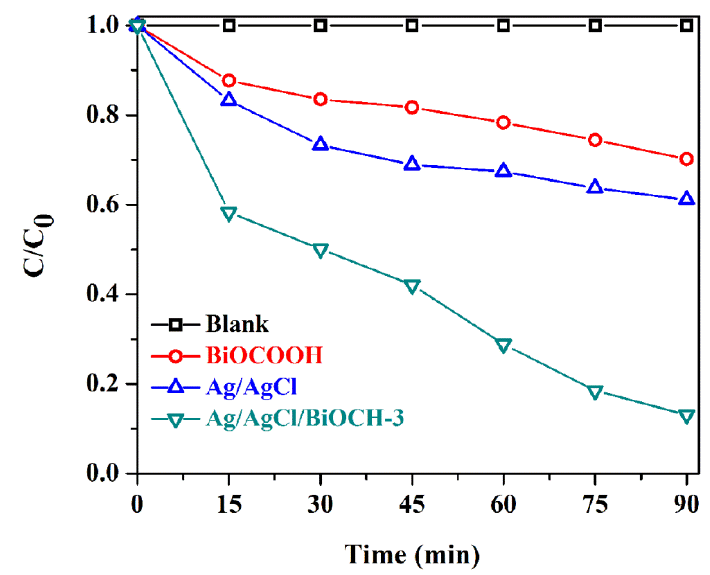
Figure 6. Photocatalytic removal of ciprofloxacin (CIP) (10 mg/L, 80 mL) over different photocatalysts (30 mg) under simulated sunlight.